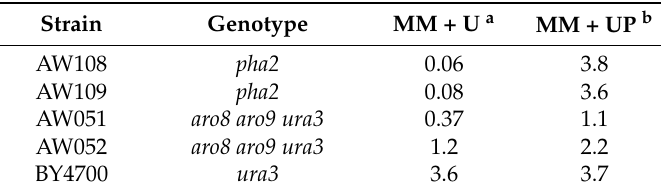
Figure 3. Viability of yeast in response to toxic phenylalanine or phenylpyruvate analogs. Cultures of yeast strains were serially diluted in water then plated onto medium containing either ( a ) L3T, 3TP, 2TP or ( b ) FPA, FPP, or ( c ) dimethyl sulfoxide, FPA. Relative viability was obtained by dividing the number of colony forming units (CFUs) from drug plates by CFUs from YPD plates. Plates were incubated for 2–3 days and CFUs counted. The average and standard deviation of three independent trials is shown. Table 3. Density of two-day-old cultures.